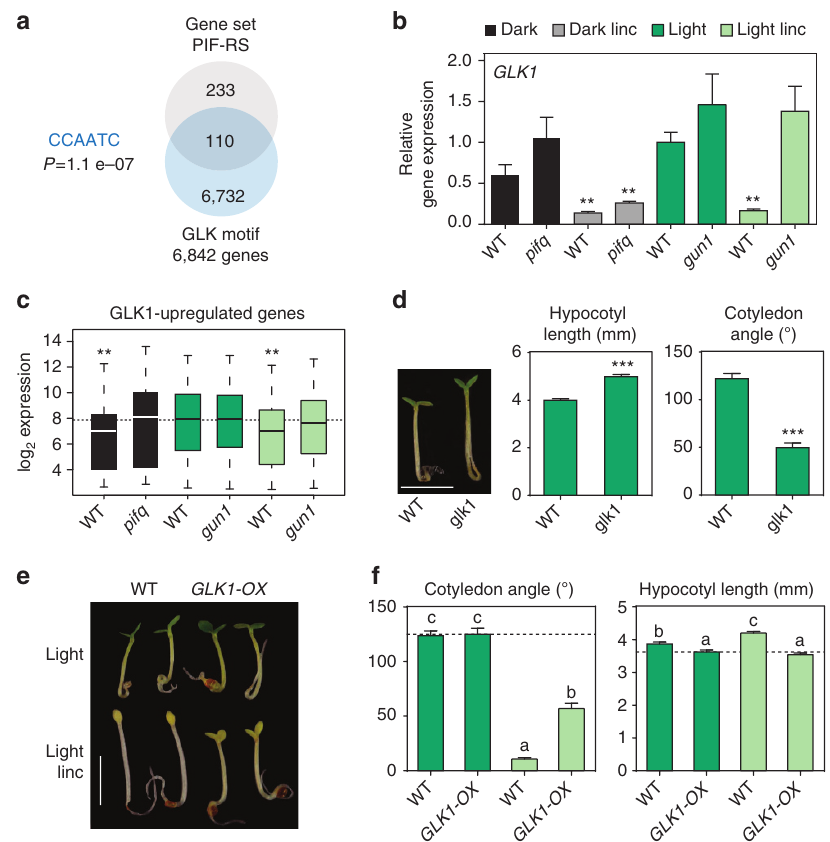
Figure 4 | Retrograde and PIF-mediated light signals antagonistically regulate deetiolation through transcriptional control of GLK1 . ( a ) Promoter regions (500bp upstream of the start codon) of PIF-RS genes are significantly enriched in putative GLK-binding motifs (CCAATC) 17 , present in 6,842 promoter regions in the Arabidopsis genome. ( b ) GLK1 is a gene whose expression is repressed by the PIFs in the dark and by lincomycin in a GUN1- dependent fashion in the light. Transcript levels of GLK1 analysed by qRT–PCR in 3-day-old WT, pifq and gun1 seedlings grown in the dark or in continuous white light in the absence (Dark and Light, respectively) or presence (Dark linc and Light linc, respectively) of lincomycin. Values were normalized to PP2A , and expression levels are expressed relative to WT light set at one. Data are the means ± s.e.m. of biological triplicates ( n ¼ 3). ( c ) GLK1-induced genes display a pattern of expression similar to GLK1 . Transcript levels were obtained from refs 11 and 23, for a set of 93 genes previously defined as GLK1- induced 17 , which are represented in the ATH1 array. Statistically significant differences from WT Light by heteroscedastic t- test are indicated (** P o 0.01). ( d ) GLK1 promotes photomorphogenesis under continuous white light. WTand glk1 mutant seedlings grown for 3 days in the light display a hyposensitive phenotype with partially closed cotyledons and longer hypocotyls. Scale bar, 2.5 mm. ( e ) Seedlings overexpressing GLK1 display insensitivity to lincomycin and partially deetiolate in the presence of lincomycin. WTand GLK1-OX seedlings were grown for 3 days in white light in the absence (Light) or presence (Light linc) of lincomycin. Scale bar, 2.5 mm. ( f ) Cotyledon angle and hypocotyl length of seedlings grown as in e. Letters denote the statistically significant differences among means by Tukey-b test ( P o 0.05). Error bars in d , f represent s.e.m. of two independent experiments ( n Z 20). In b and d , statistically significant differences from light-grown WT seedlings by Student’s t -test are shown (** P o 0.01 and *** P o